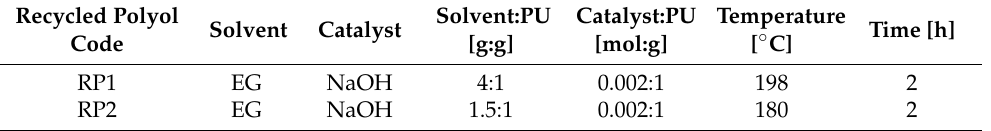
Table 1. Conditions of the glycolysis